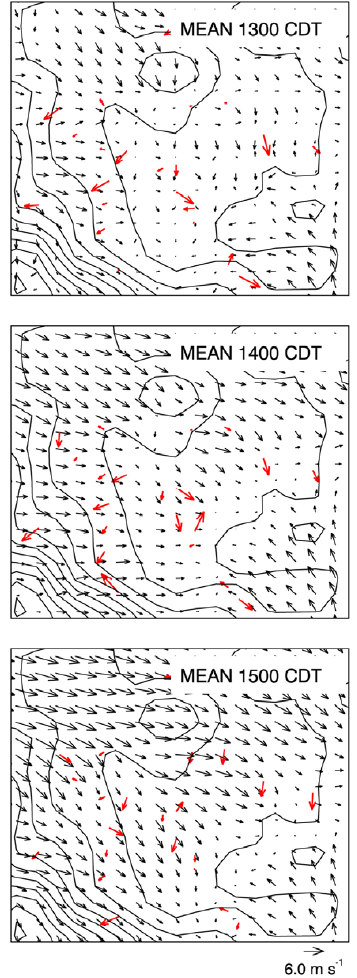
with the measurements (red arrows) at the RAMA sites around the Mexico City basin for 13:00 CDT, 14:00 CDT, and 15:00 CDT on 3 March